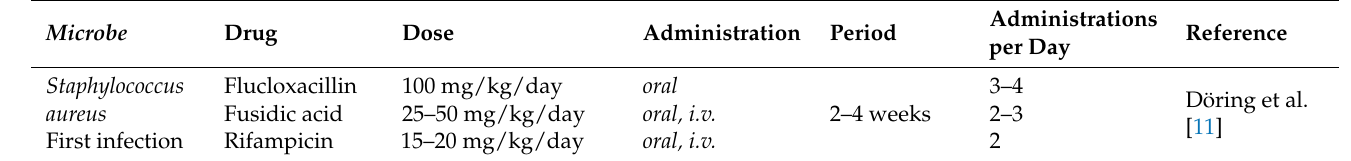
Table 2. Recommended antibiotics for Staphylococcus aureus infection in CF